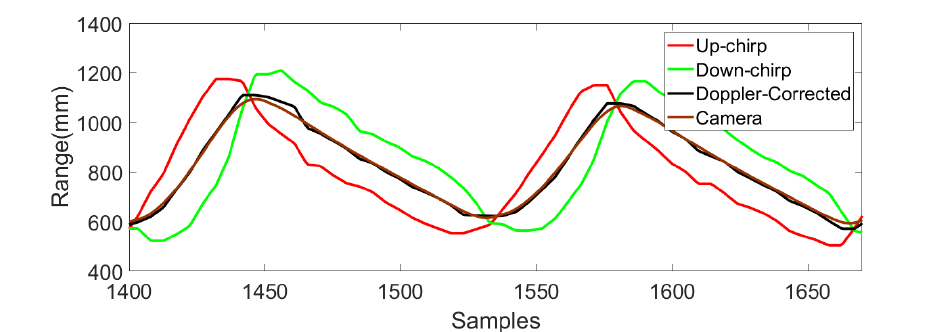
Figure 8. The comparison of the range measurements from one of the lower limbs to a fixed anchor node extracted from the proposed ultrasonic system using up-chirp, down-chirp, a mean of up and down-chirp and motion capture system for a walking speed of 0.83